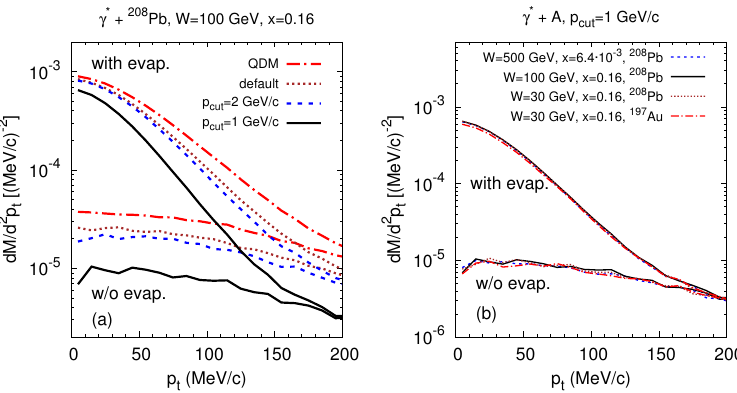
Figure 6. Neutron transverse momentum spectra for γ ∗ +nucleus deep inelastic collisions. ( a ) Spectra for fixed photon kinematics W = 100 GeV, x = 0.16 on the 208 Pb target with different prescriptions for hadron formation (line notations are the same as in Figure 5). Upper (lower) lines show calculations with (without) statistical evaporation. ( b ) Spectra for the different photon kinematics and nuclear targets as indicated calculated with p cut = 1